Question: What does this figure show? Answer in one sentence.
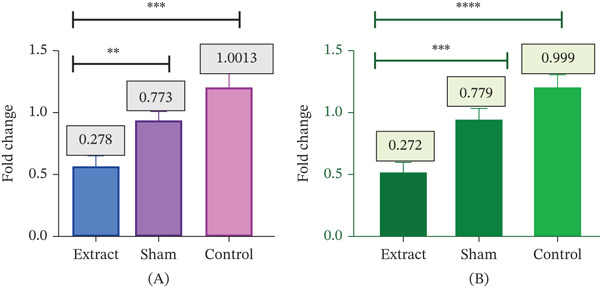
Answer: Fold change analysis of ureC (left) and uafA (right) gene expression in SS2 isolate treated with ethanolic extract at sub‐MIC concentration, sham, and control. Significant downregulation of both genes was observed in the extract‐treated groups compared with the control, as indicated by asterisks ( p < 0.05).